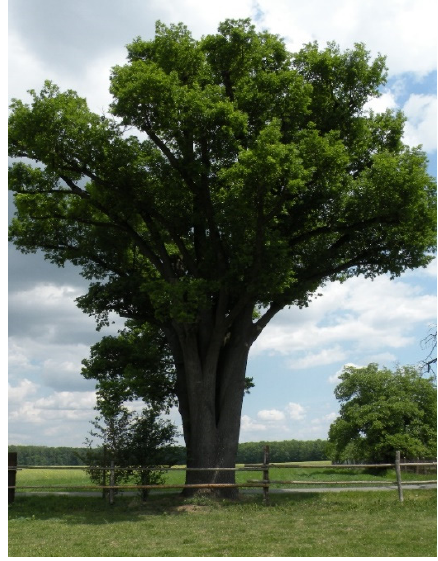
Figure 3. Free-growing heritage oak tree.